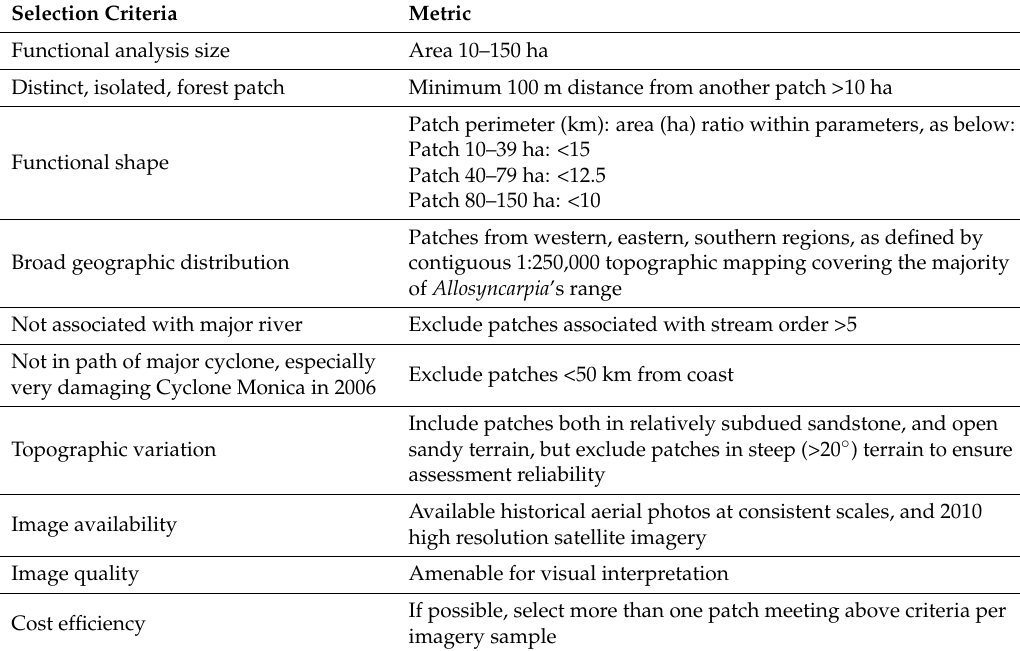
Table 1. Selection criteria for canopy cover change